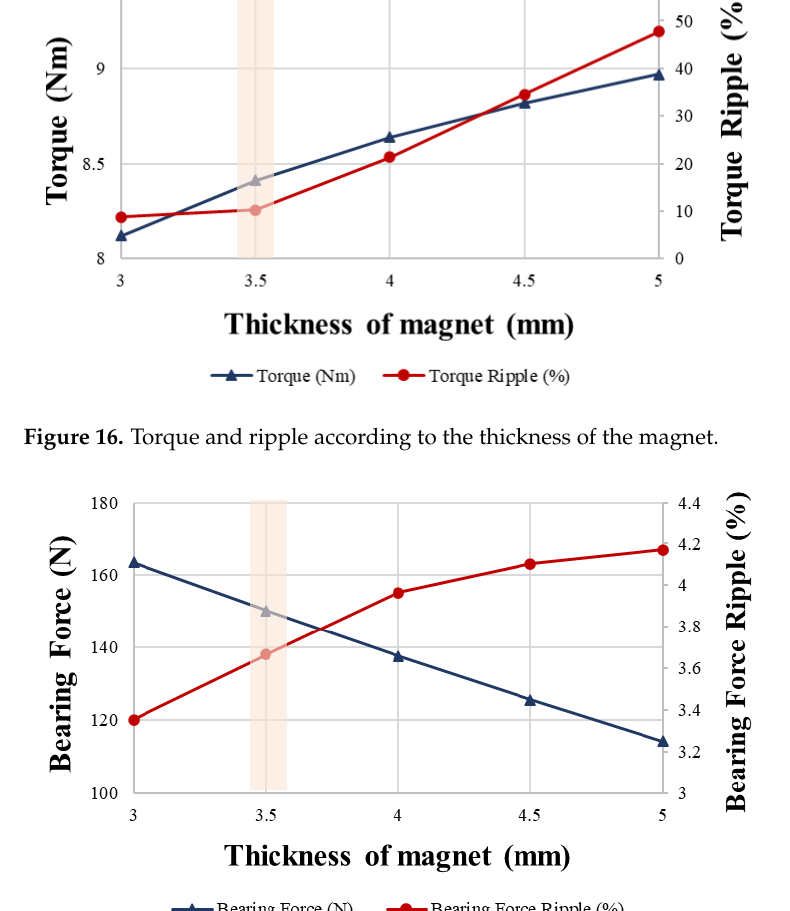
Figure 17. Bearing force and ripple according to the thickness of the magnet.